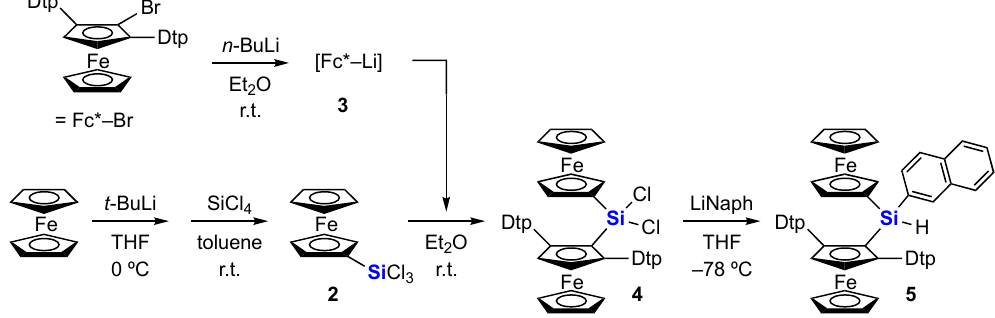
Scheme 1. Preparation of bis(ferrocenyl)dichlorosilane 4 and its reduction with lithium naphthalenide.